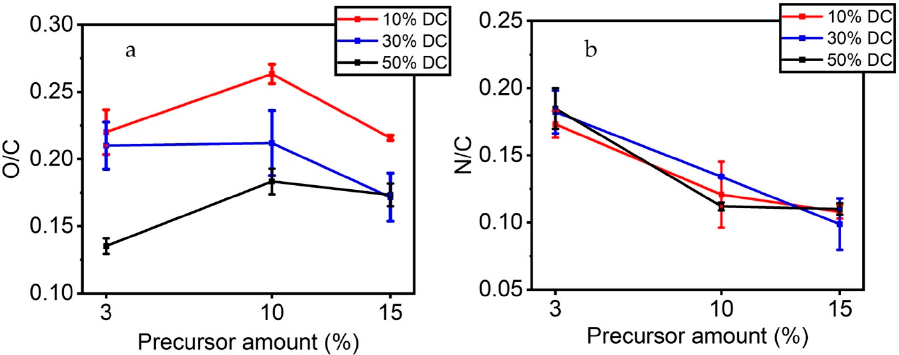
Figure 3. ( a ) O/C and ( b ) N/C ratios of the plasma-coated ETFE samples as function of the precursor amount and applied DC.